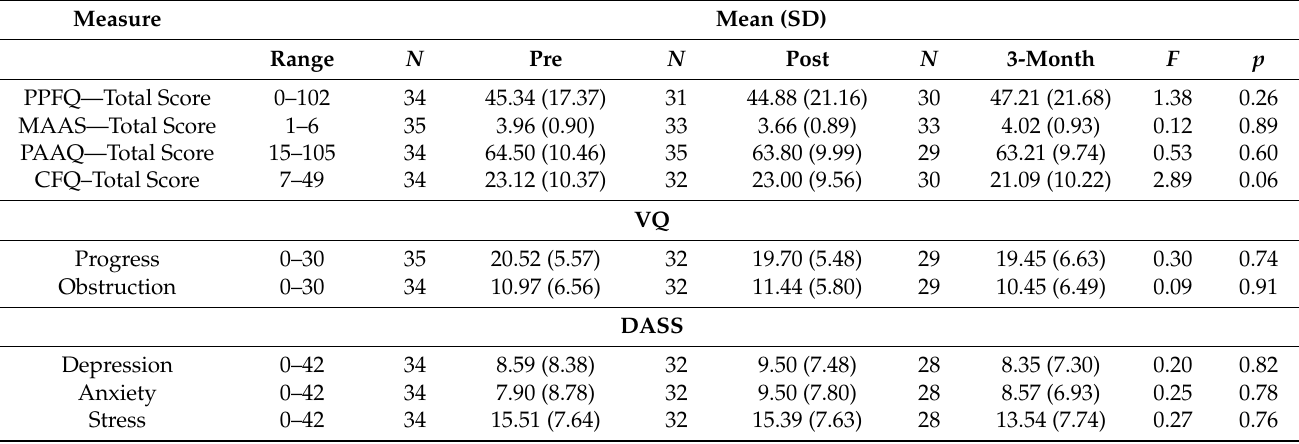
Table 5. Preliminary outcome